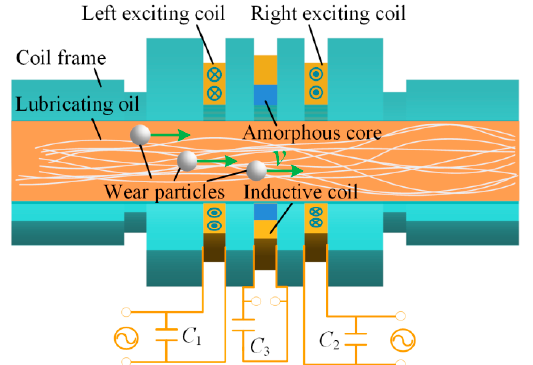
Figure 1. The structure of the proposed wear particle detector.